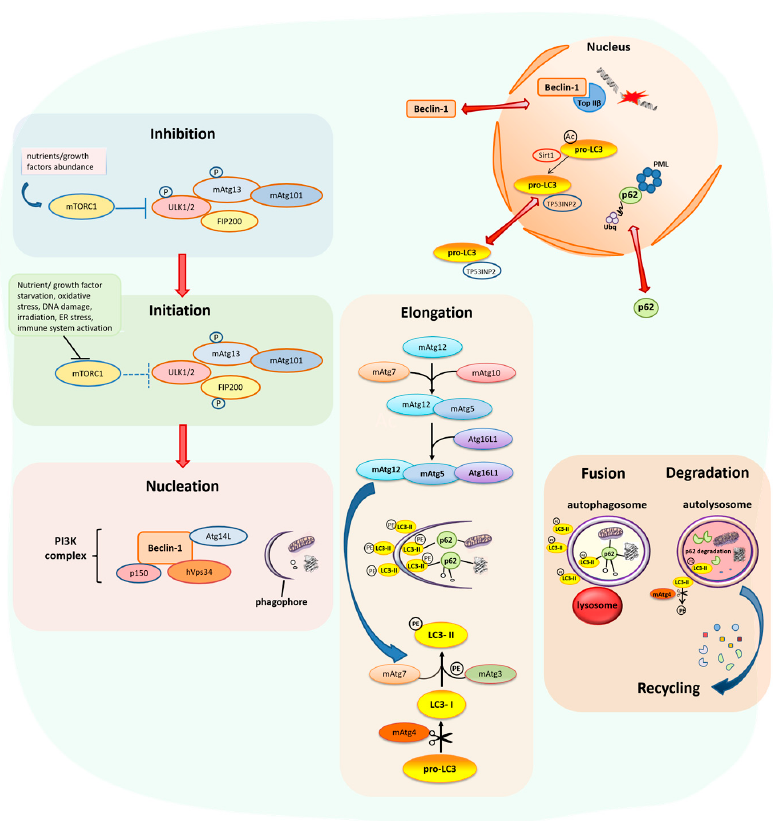
Figure 1. Stages of autophagy. When nutrients and growth factors are abundant, mammalian target of rapamycin complex 1 (mTORC1) associates with and inhibits (T bar, solid line) the ULK1/2-mAtg13-mAtg101-FIP200 complex (ULK complex) by phosphorylation of unc-51-like kinase 1/2 (ULK1/2) and mAtg13. Under starvation and other stress conditions, mTORC1 dissociates (T bar, dotted line) from ULK1/2 leading to its dephosphorylation and allowing it to subsequently phosphorylate focal adhesion kinase family-interacting protein of 200 kDa (FIP200) and mAtg13 triggering (red arrow) the initiation of